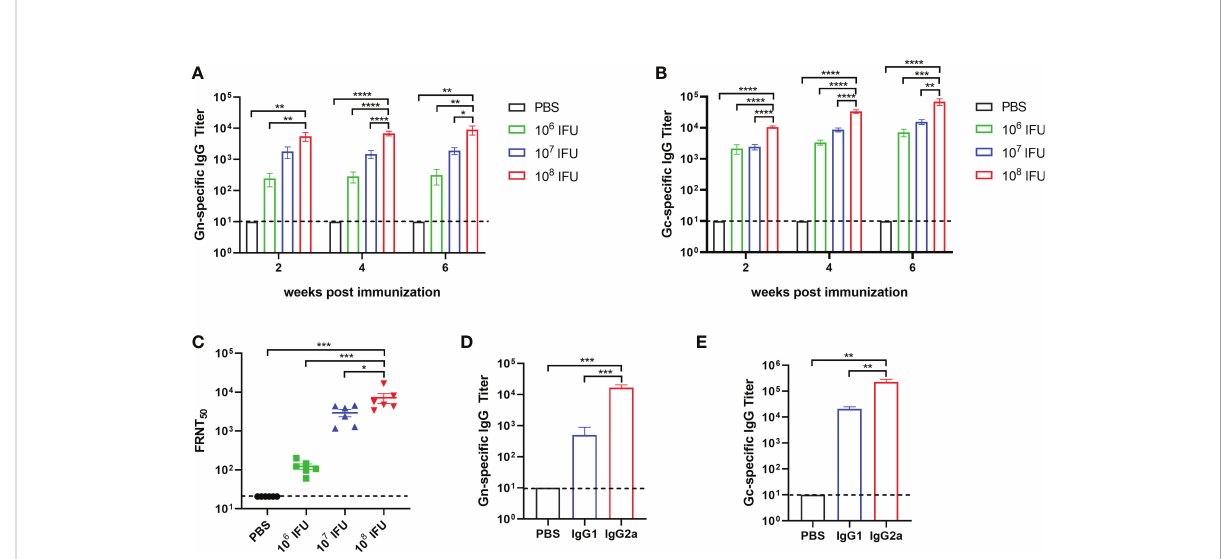
FIGURE 2 Humoral immune response in Ad4-GnGc-vaccinated mice. Groups of BALB/c mice (n = 6) were immunized with a single dose of 10 6 , 10 7 or 10 8 IFU of Ad4-GnGc or with PBS via the intramuscular route. Sera were collected 2, 4, and 6 weeks after immunization. RVFV Gn- (A) and Gc- (B) speci fi c IgG antibody titers were determined by ELISA. (C-E) Sera from the high dose group collected on day 28 after immunization were used to determine the titers of neutralizing antibodies (C) and Gn- (D) and Gc-speci fi c (E) IgG subclasses. Data are shown as the mean ± SEM. P values were calculated by one-way ANOVA with multiple comparison tests. * P < 0.05, ** P < 0.01, *** P < 0.001, **** P <